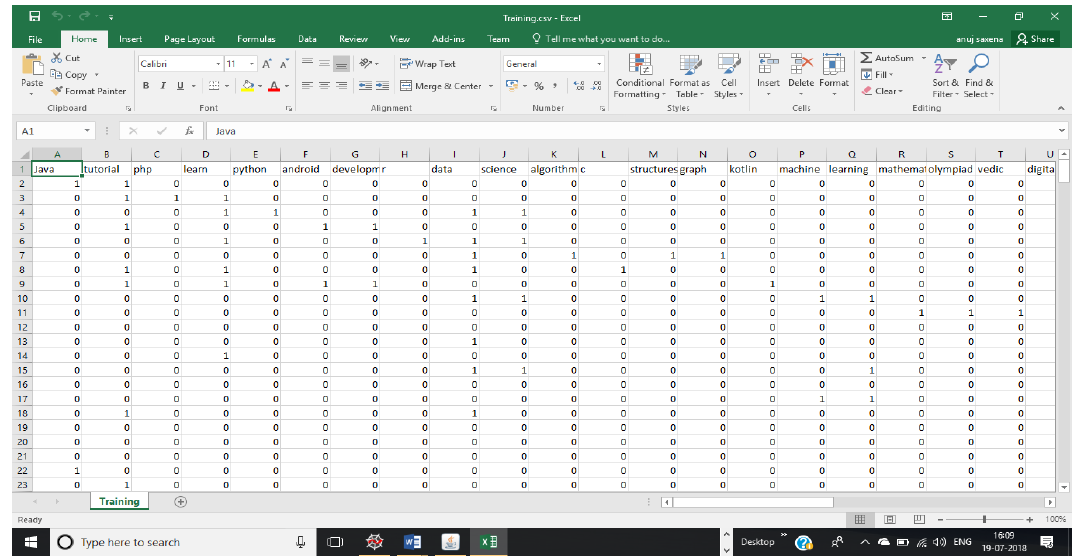
Figure 4. Classified dataset created